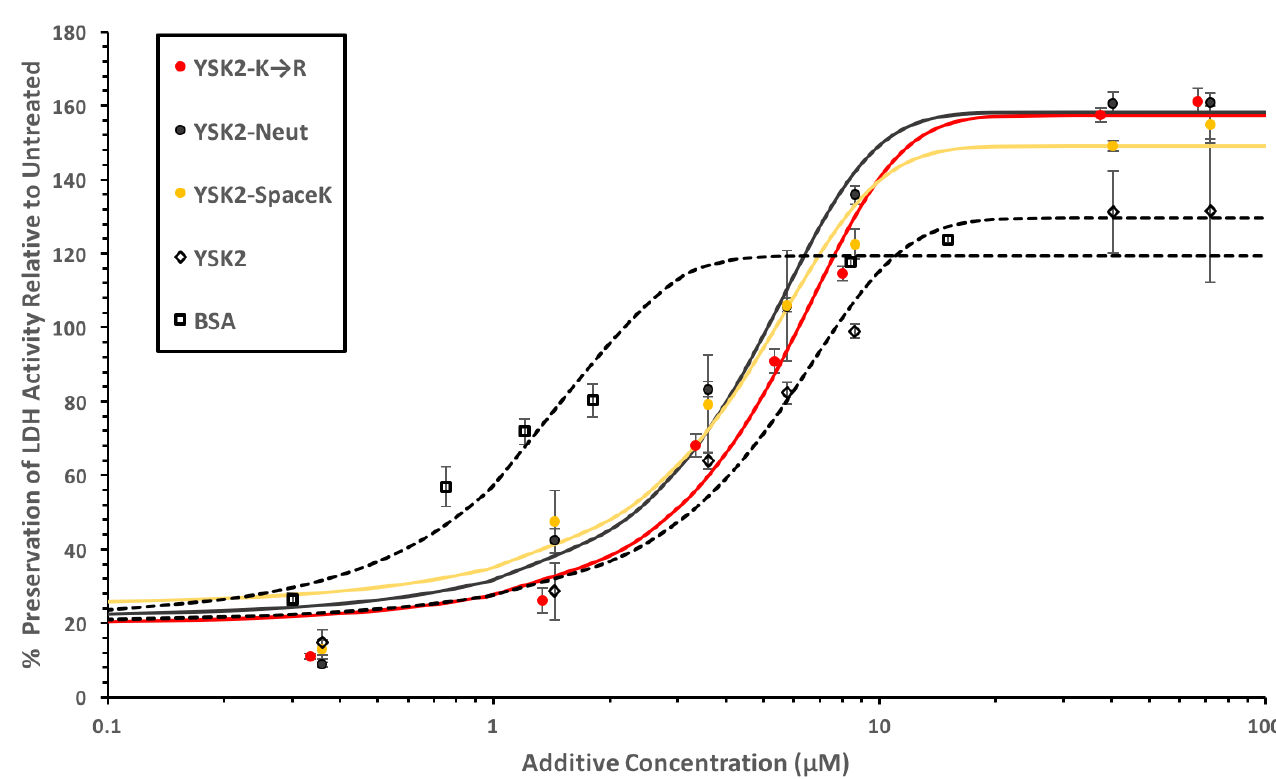
Figure 3. Cryoprotection of LDH by the YSK 2 constructs. The LDH assay was performed as described by [31]. The legend is shown as a figure inset. Lines were fitted using the equation described in Section 2, where the percent LDH preservation is relative to untreated LDH in the absence of additives. Red line, YSK 2 -K → R; solid black line, YSK 2 -Neutral; YSK 2 -SpaceK, yellow line; YSK 2 , dashed line with diamond symbols; BSA, dashed line with square symbols.